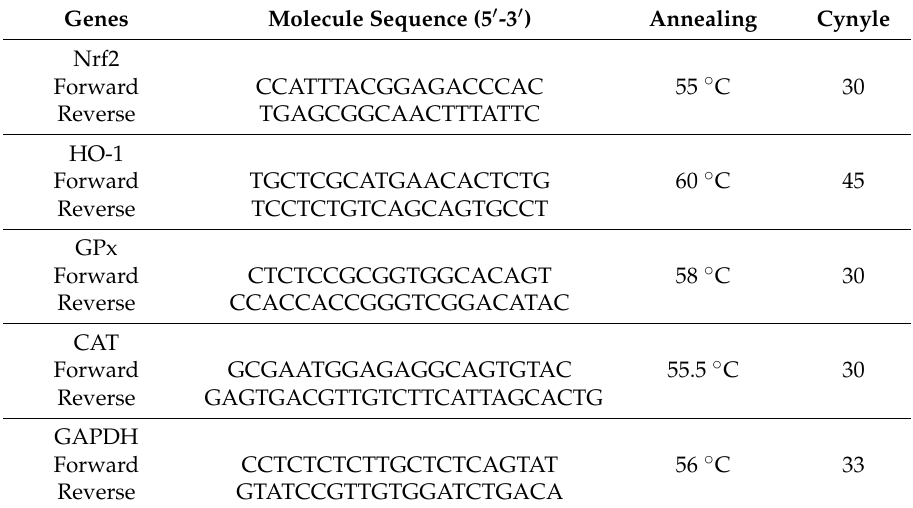
Table 1. RT-PCR primer